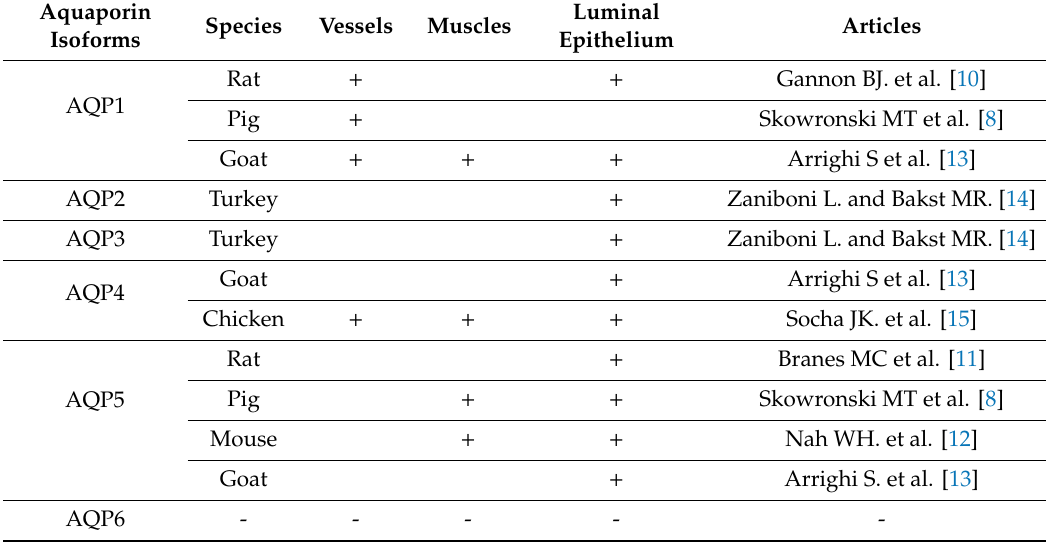
Table 1. Expression of aquaporin isoforms in oviductal